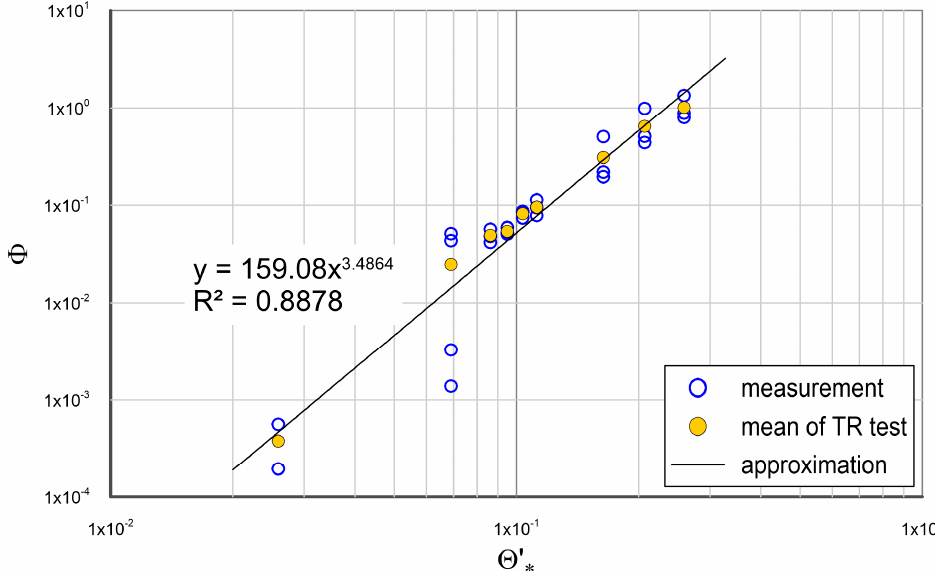
Figure 3. The approximation of transport measurements (Gda´nsk 2021 experiments) and the mean values of measurement tests by curve with a coefficient of determination 𝑅 (cid:2870) = 0.8878 . The collected samples were subject to granulometric analysis in the geotechnical la- boratory of the Koszalin University of Technology. For this purpose, a Micro LAB sieve shaker (model: LPzE-2e) was used. Measurements were made using the “dry” method for all sediment samples. The samples were dried at 100 ± 0 °C for 24 h before granulometric analysis. Examples of measured grain size distributions for flows of 8 l/s and 14 l/s are shown in Figure 4.